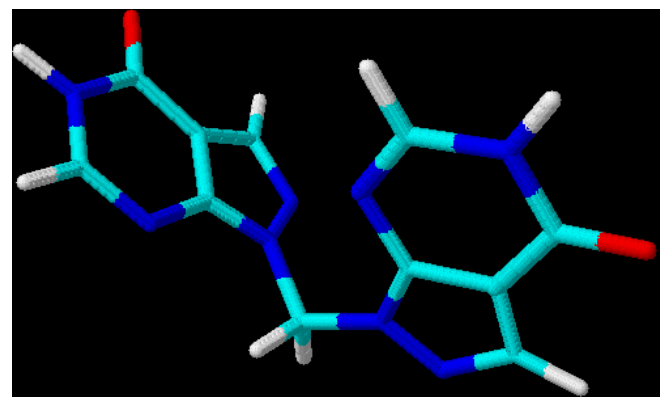
Figure 2 . 3D-Optimized structure of compound 3b [19].